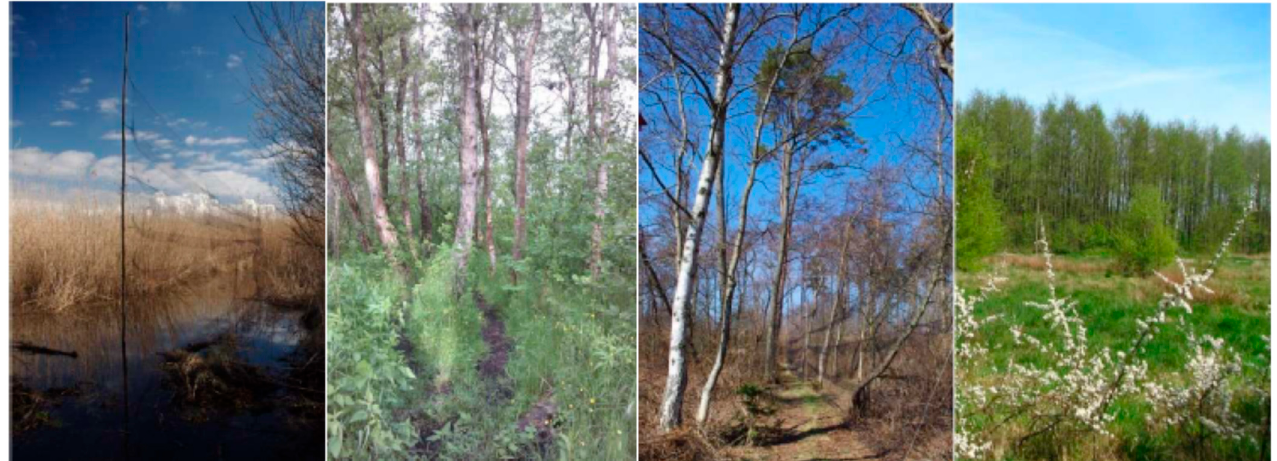
Figure A1. Location of the bird ringing station Bukowo at the Baltic coast of Poland and its two locations (green symbols) combined as one ringing site: Kopa ń (54°27 ′ 11 ″ N, 16°24 ′ 08 ″ E) and Bukowo (54°20 ′ 13 ″ N, 16°14 ′ 36 ″ E). Map on the right after Google Maps, 2002, modified.